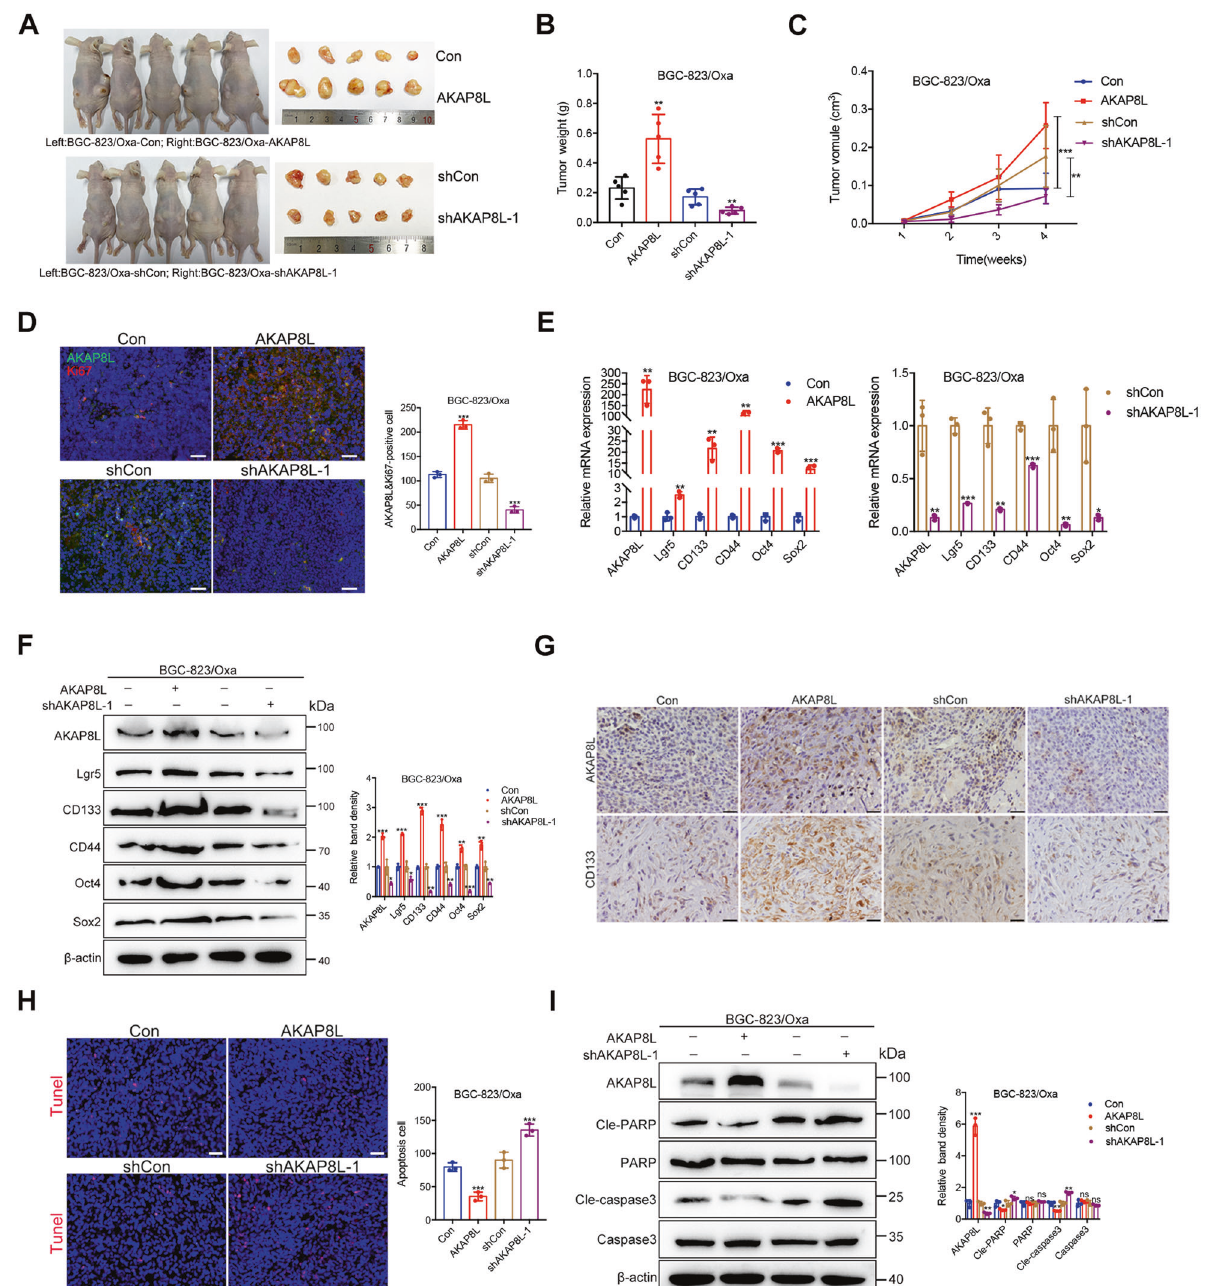
Fig. 4 AKAP8L controls the chemoresistance in vivo. A 1 × 10 6 AKAP8L-overexpressing or AKAP8L-knockdown BGC-823/Oxa were implanted in nude mice (tumor development following treatment with Oxa once a week), tumors were dissected and representative images of the tumors are shown. B , C Tumor growth curves for orthotopic models. D Representative images of immuno fl uorescence staining of AKAP8L, Ki- 67 and quanti fi cation analysis of AKAP8L, Ki-67 positive cells in xenograft tumors. Scale bar indicates 50 μ m. E , F qPCR and Western blot analysis of the expression of AKAP8L, Lgr5, CD133, CD44, Oct4, and Sox2 in xenograft tumors. G Representative immunohistochemical staining of AKAP8L and CD133 in the indicated tumor tissues. Scale bar indicates 20 μ m. H Immuno fl uorescence staining of TUNEL was performed to evaluate the apoptotic cells. Scale bar indicates 50 μ m. I Western blot analysis of cleaved-caspase 3 and cleaved-PAPR. The values indicate the mean ± SD of three independent experiments. * P < 0.05, ** P < 0.01, *** P <